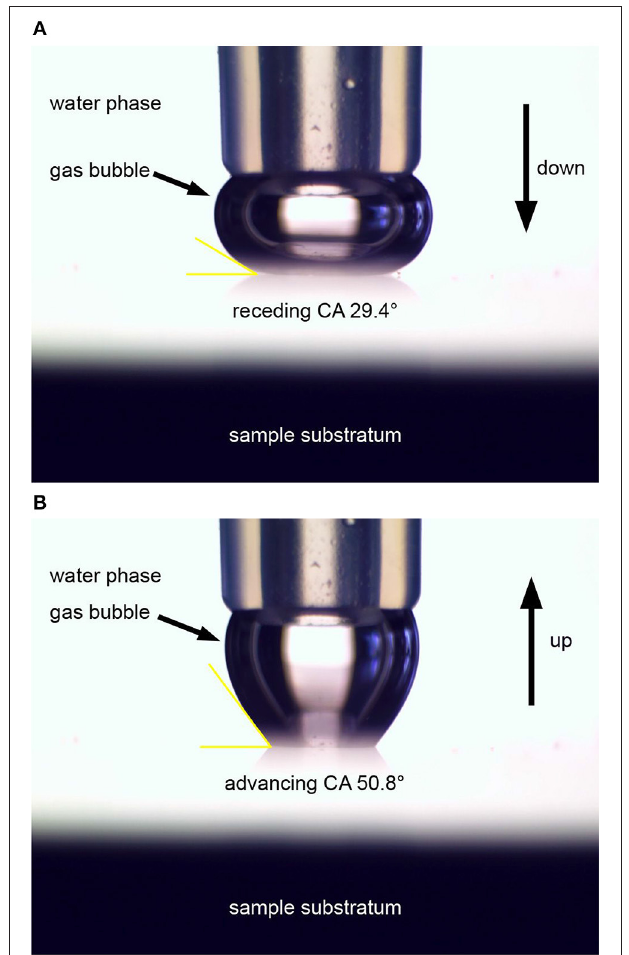
FIGURE 3 | Determination of dynamic CAs with a captive bubble technique for fully-hydrated biofouled surfaces: (A) receding CA; (B) advancing CA.